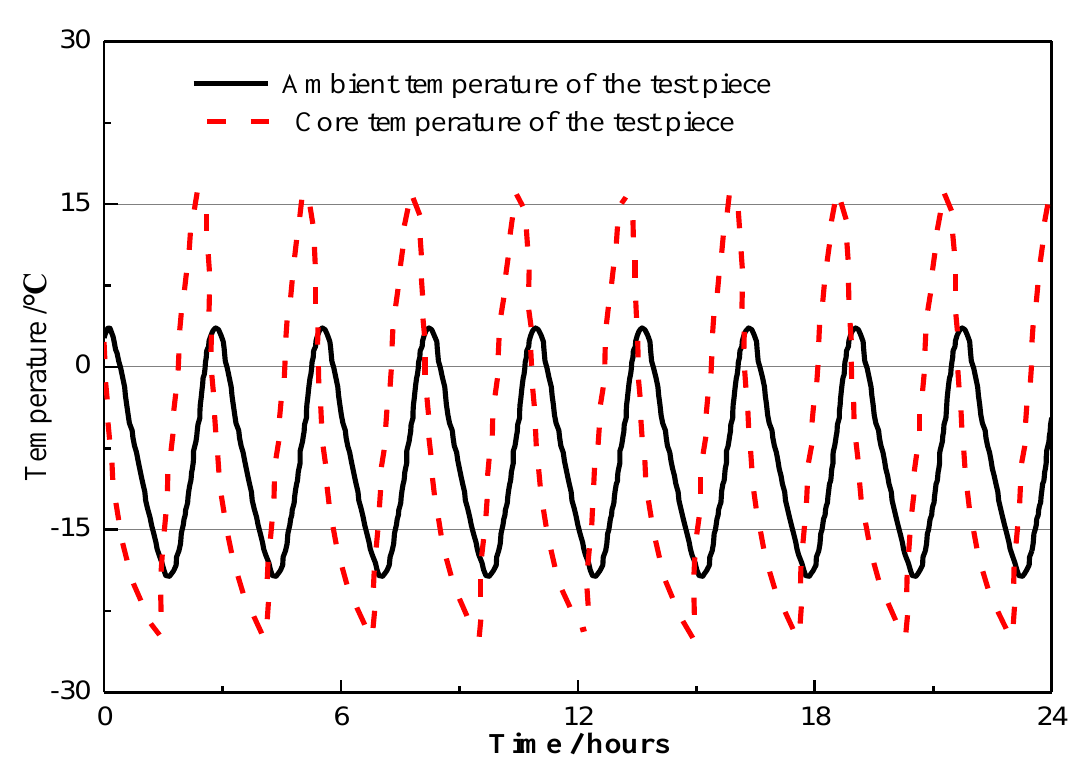
Figure 3. Temperature change curve during the freeze – thaw cycles.